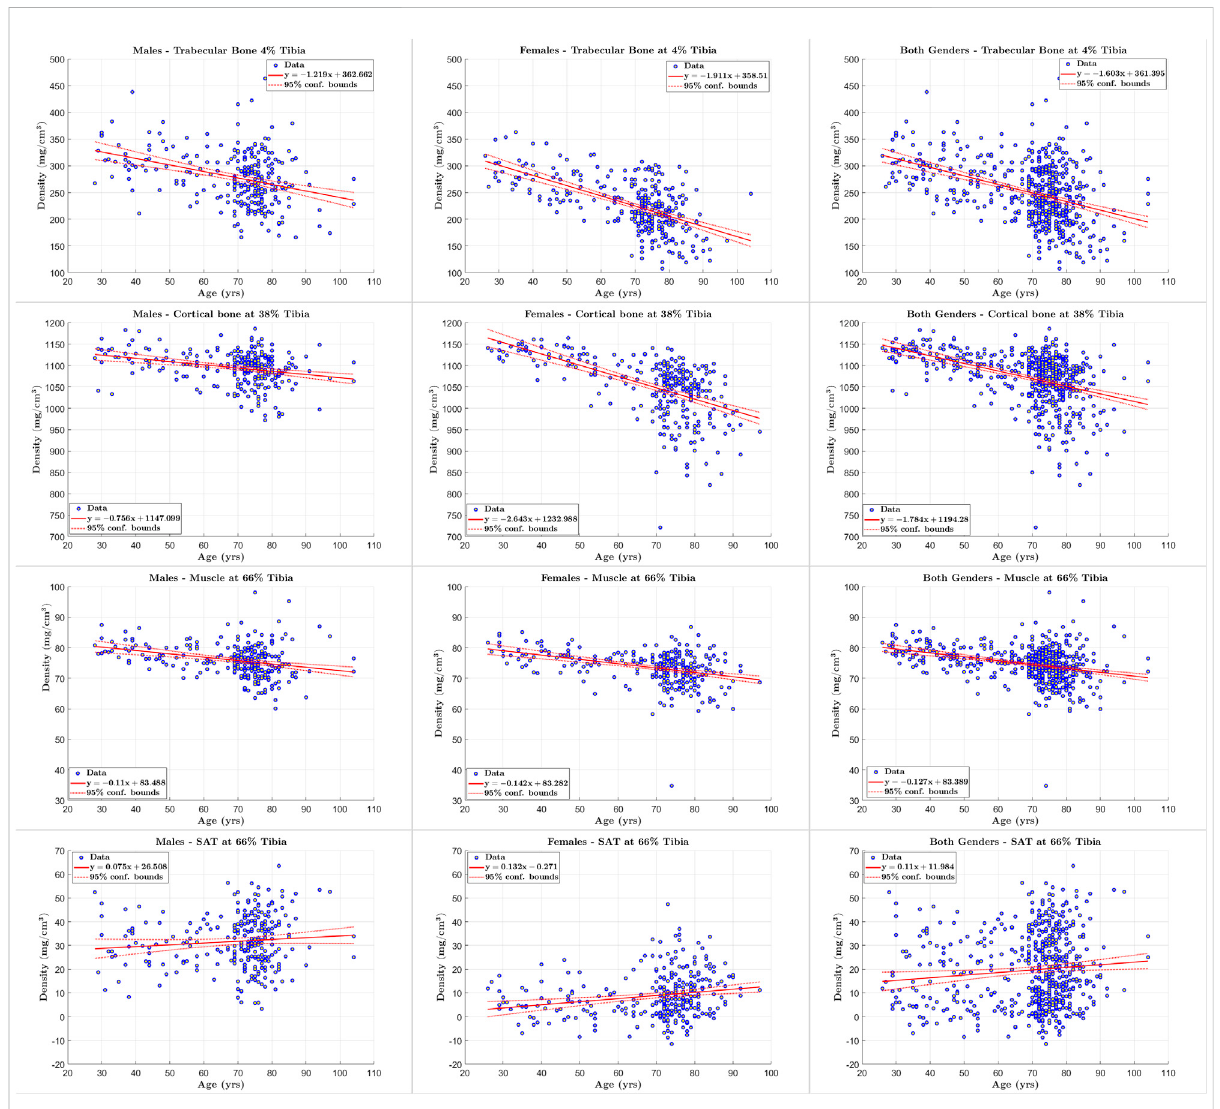
FIGURE 7 Scatter plots of tissue of interest ’ s density versus age for males, females, and both genders at 4%, 38% and 66%